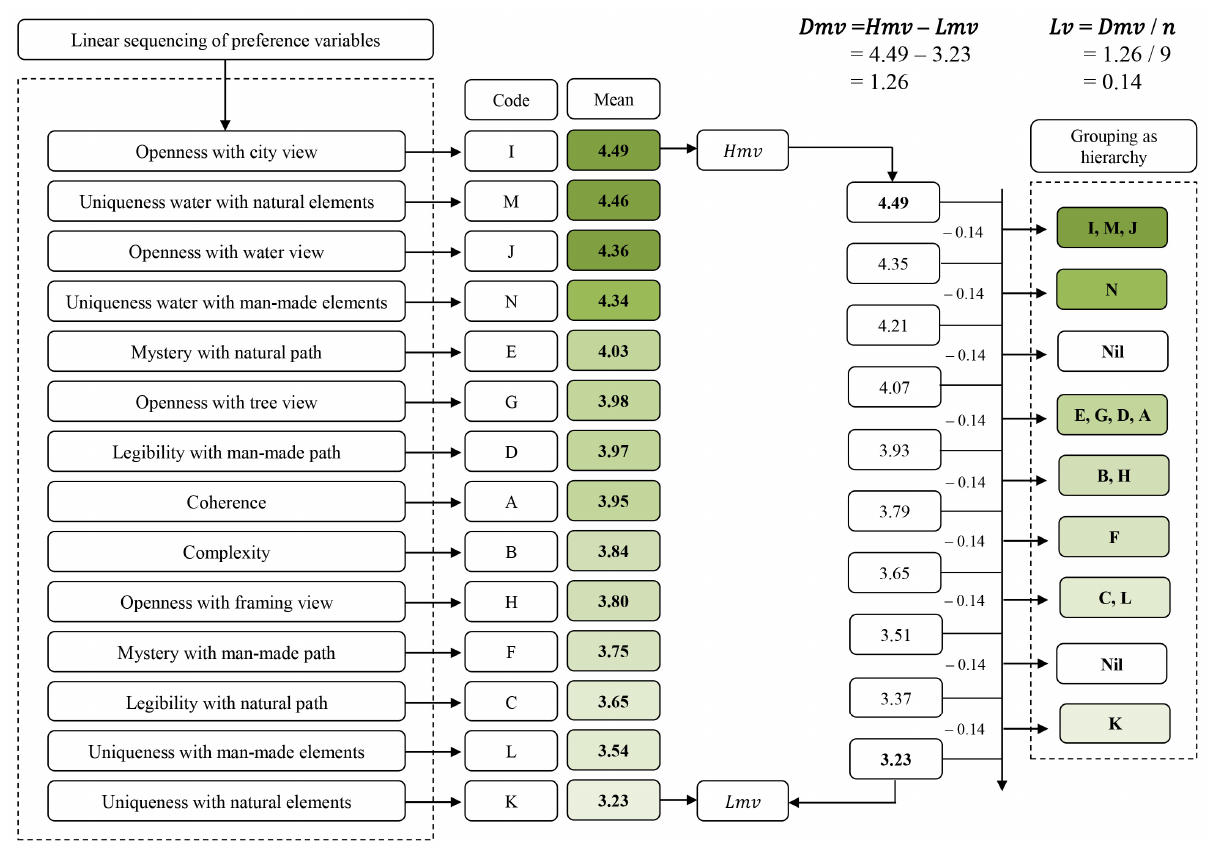
Figure 4. Linear sequencing of the importance and level of important variables. The colors repre-